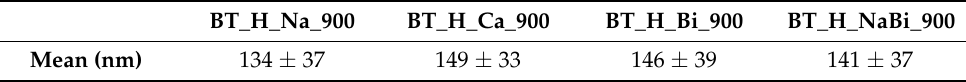
Table 5. Results of the particle size analysis from SEM micrographs for the doped samples.